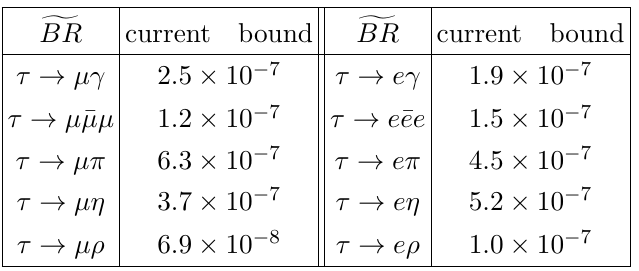
Table 2 . Current bounds on selected τ lepton flavour violating branching ratios, from Refer- ences [56, 56–61], normalised to leptonic weak decays as in eq. (A.4). here are τ → e { π , η, ρ } ; the results for τ → µ { π , η, ρ } can be obtained as in eq. 0 0